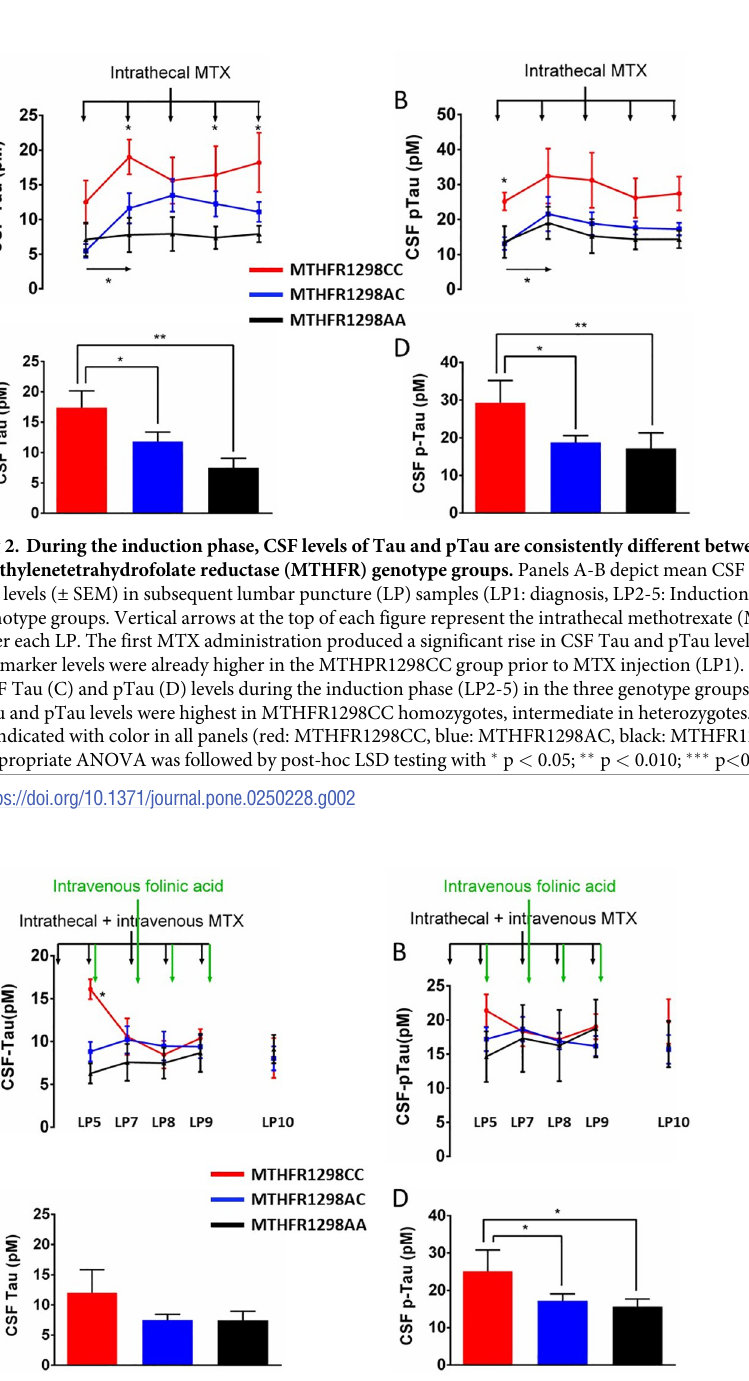
PLOS ONE | https://doi.org/10.1371/journal.pone.0250228 April 30,